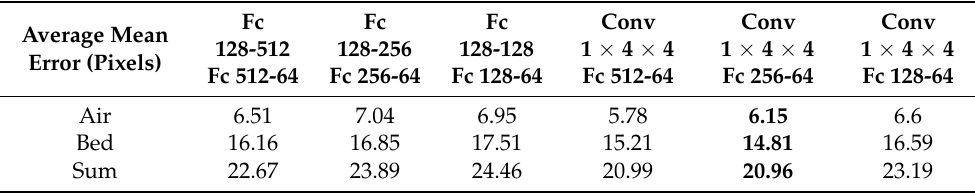
Table 2. Experiments on different classification structures.